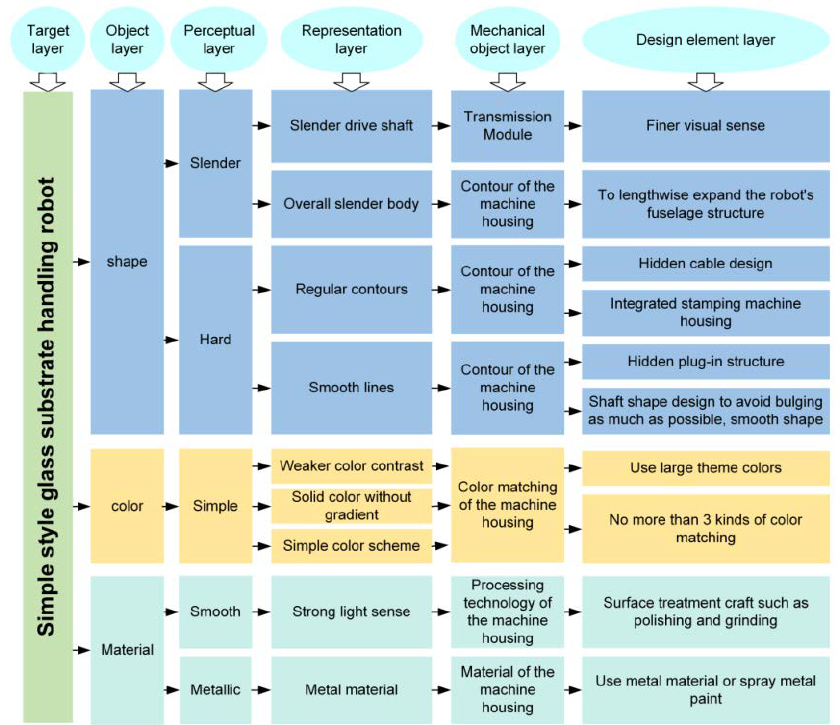
Figure 4. Relationship between perceptual design elements and mechanical